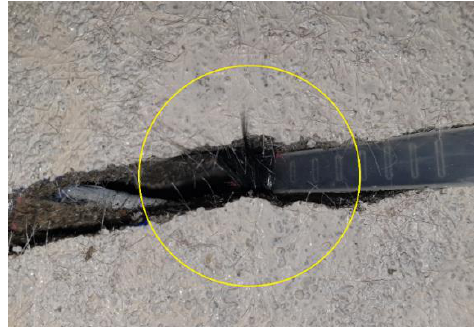
Figure 12. Rupture of textile (SN specimen).